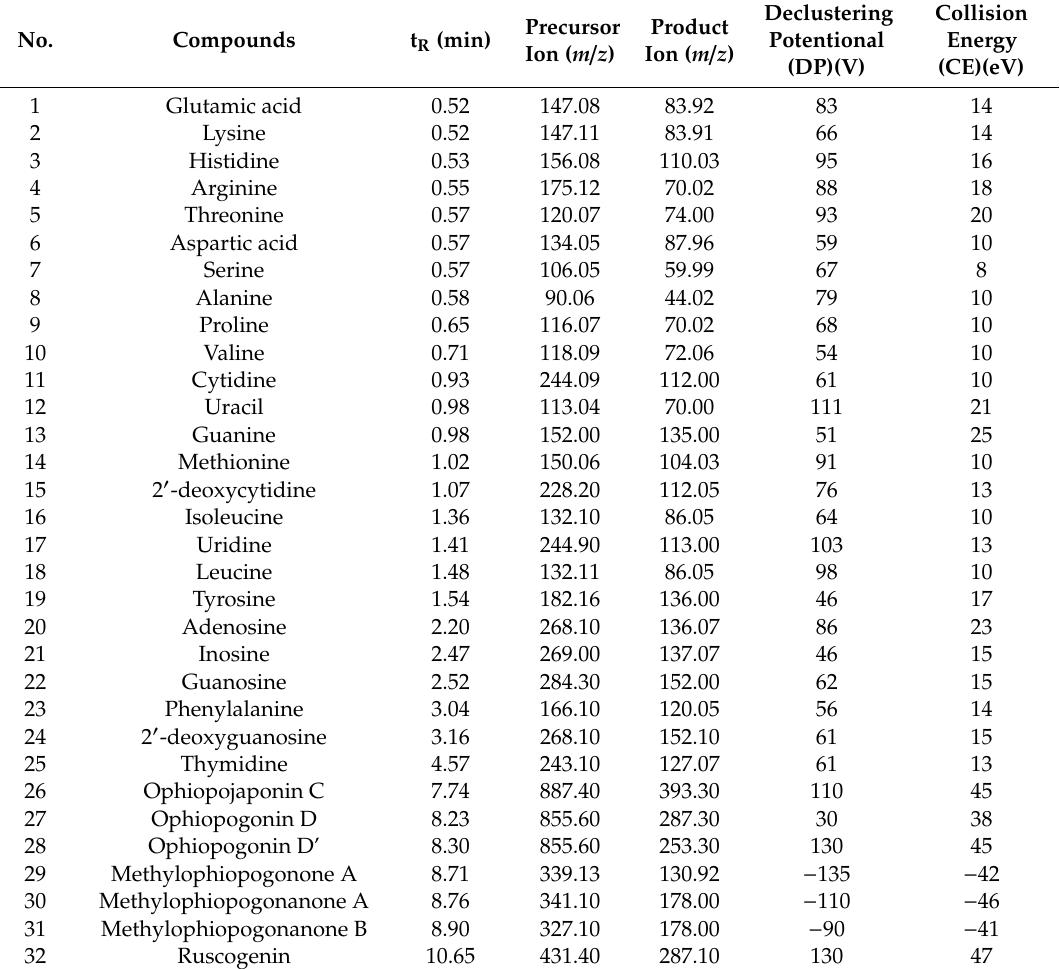
Table 1. Retention time, related mass spectrometry (MS) data of the target